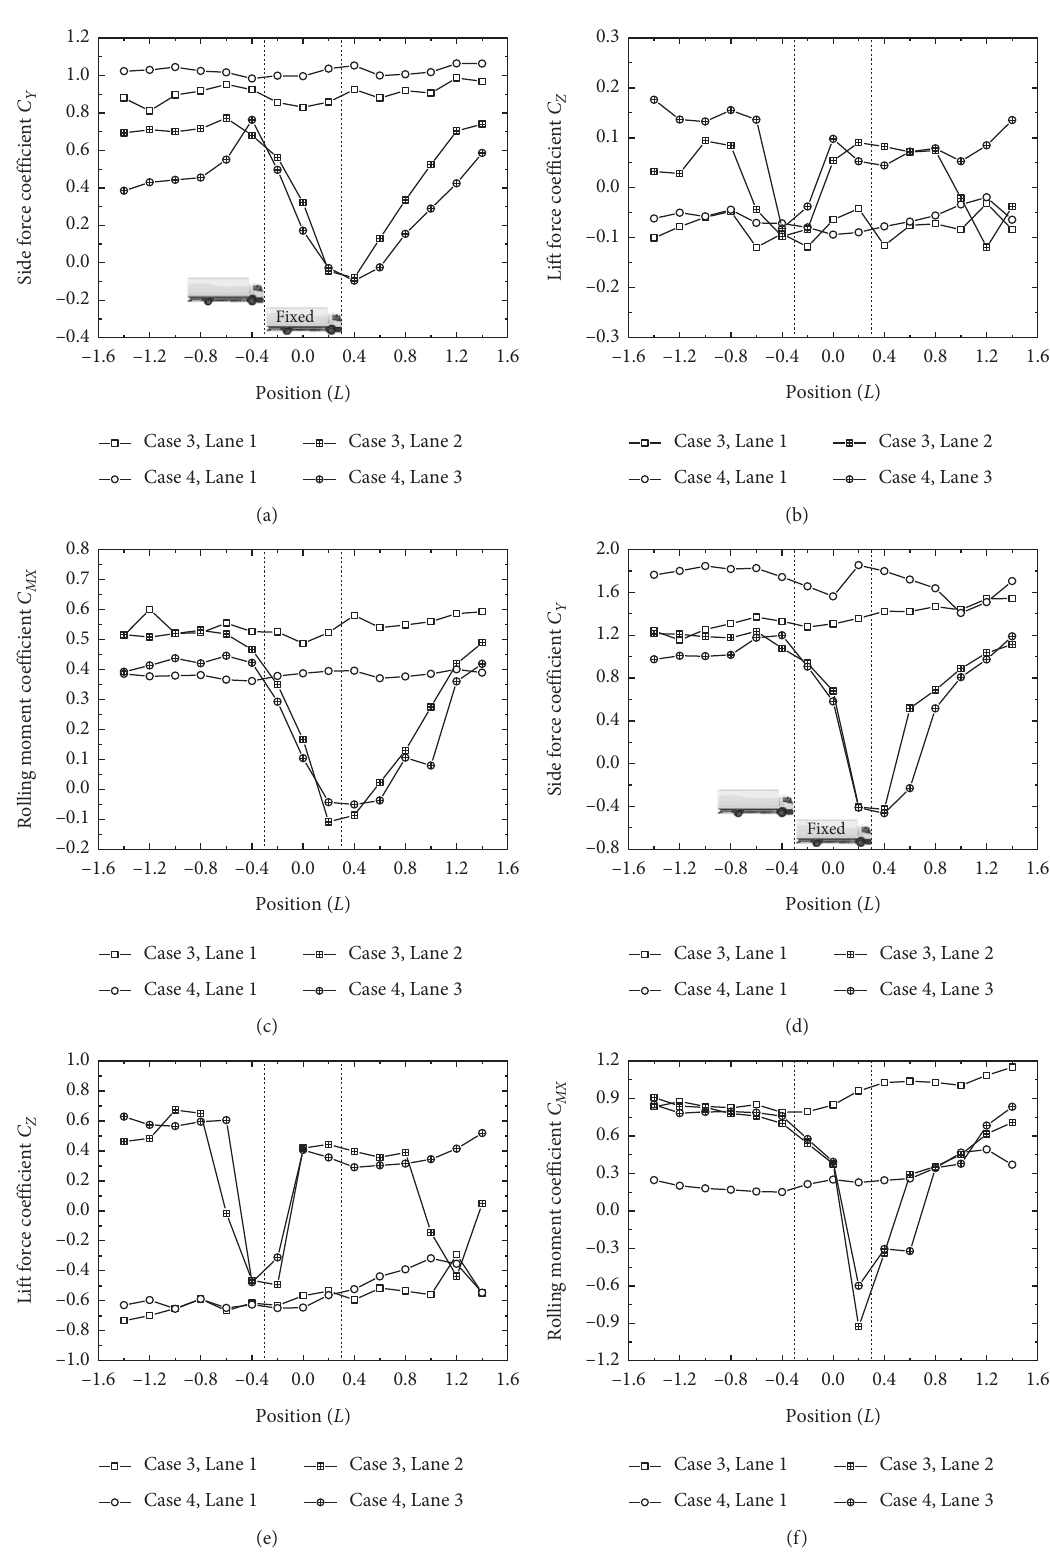
Figure 7: Aerodynamic coefficient of the van ((a), (b), (c) mean; (d), (e), (f) 3s